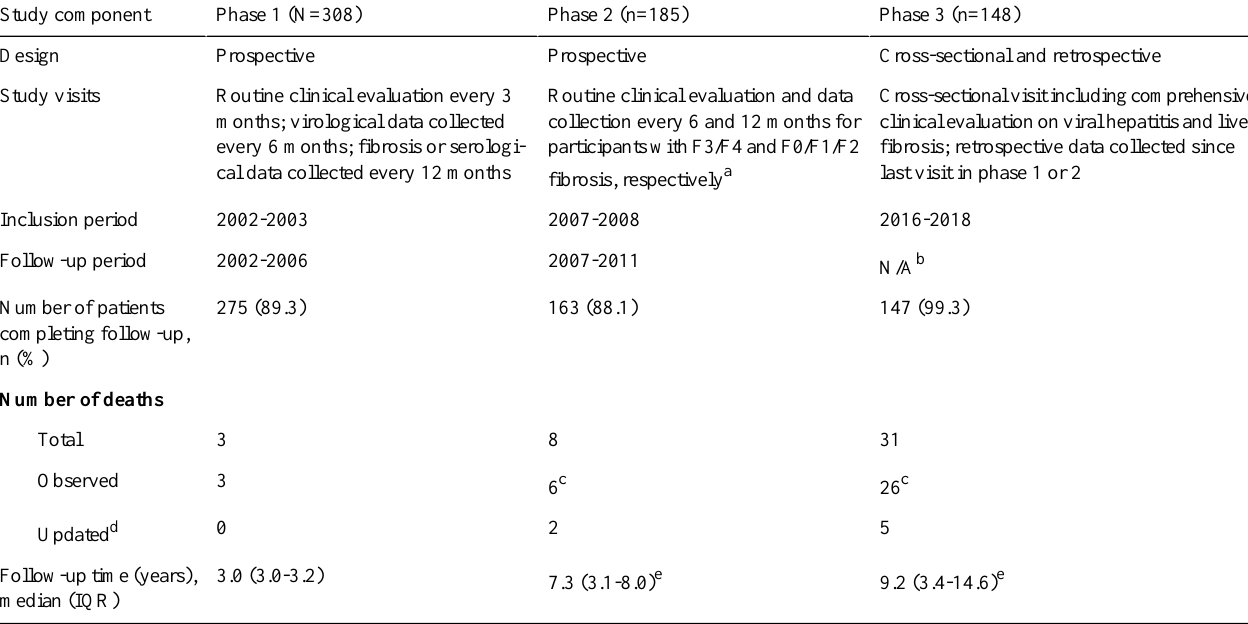
Table 1. General information at each phase of data